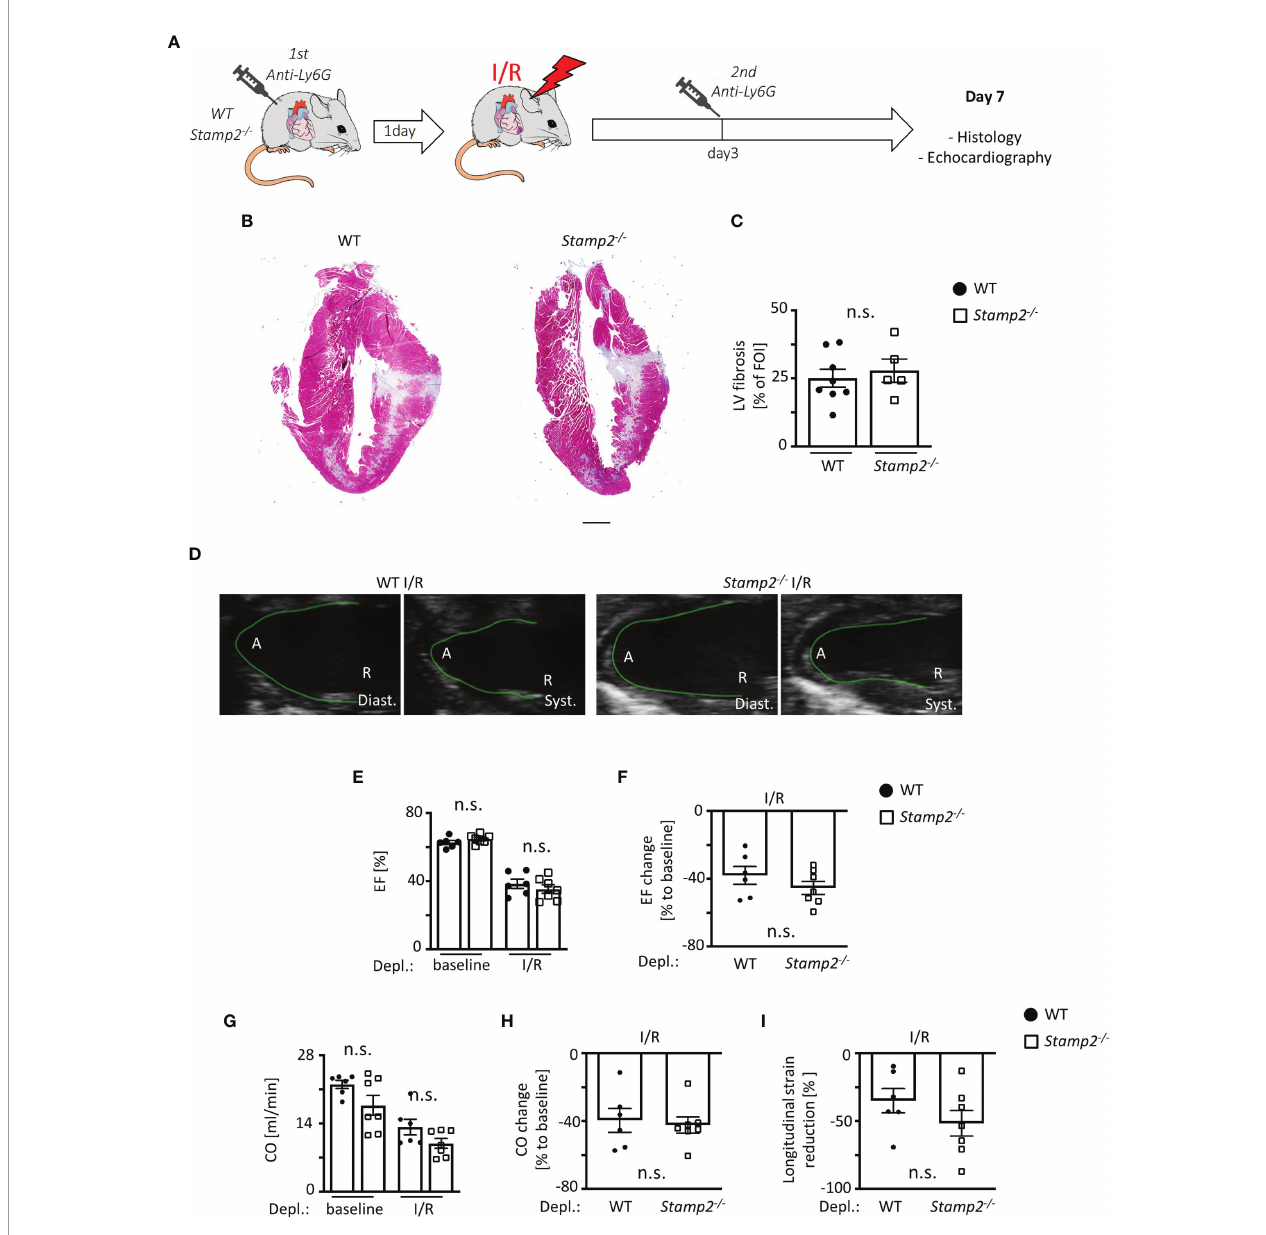
FIGURE 5 | PMN depletion rescues impaired LV function in Stamp2 -/- mice after I/R. (A) Schematic overview of PMN depletion by i.p. injection of an anti-Ly6G antibody 1 day prior to- and 3 days after subjection to I/R (13). (B) Representative images of Masson ’ s trichrome-stained cardiac sections of WT- and Stamp2 -/- animals 7 days after I/R with (C) assessment of the LV fi brotic areas stained in green/grey (n=8/5). Scale bar=1mm (D) Representative echocardiographic recordings of WT- and Stamp2 -/- hearts (A=Apex, R=Aortic root; Diast.=diastole, Syst.=systole). (E) Total ejection fraction (EF, n=6/7/6/7) and (F) change of EF in % to baseline (n=6/7). (G) Total cardiac output (CO, n=6/7/6/7) and (H) change of CO in % to baseline as assessed by echocardiography (n=6/7). (I) Longitudinal strain reduction after subjection to I/R (n=6/7). Baseline echocardiography was directly performed before MI induction and I/R echocardiography at day 7. Graphs show Mean